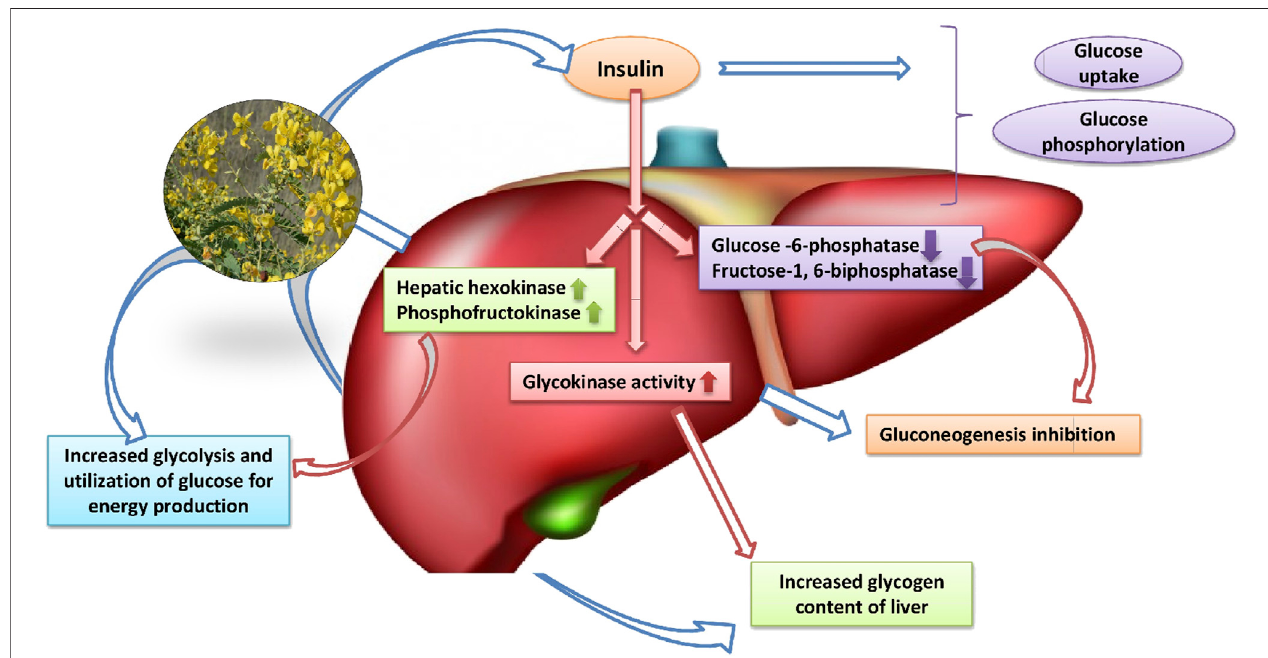
FIGURE 5 | Diagrammatic presentation of the hepatic pathways and role of liver involved in the anti-diabetic action of Senna auriculata (L.) Roxb.